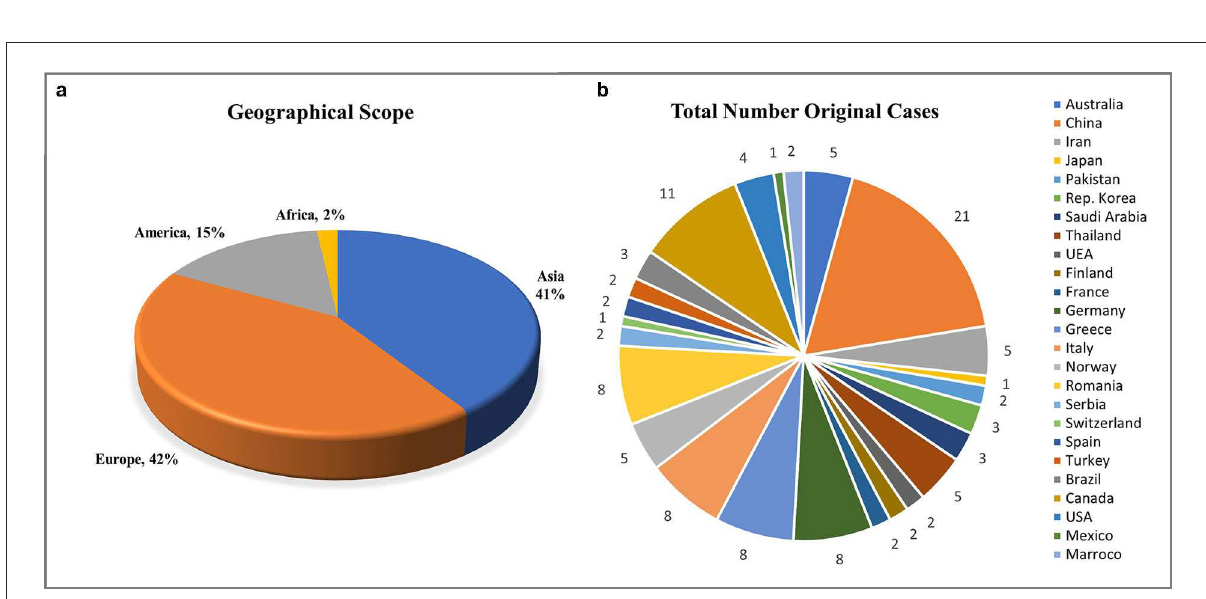
FIGURE2 (a) Geographical scope and (b) the number of original case